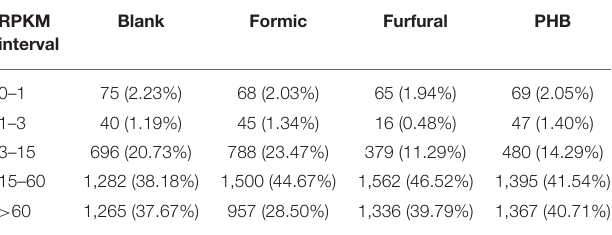
TABLE 3 | Statistics of the genes at different expression-level intervals. RPKM interval